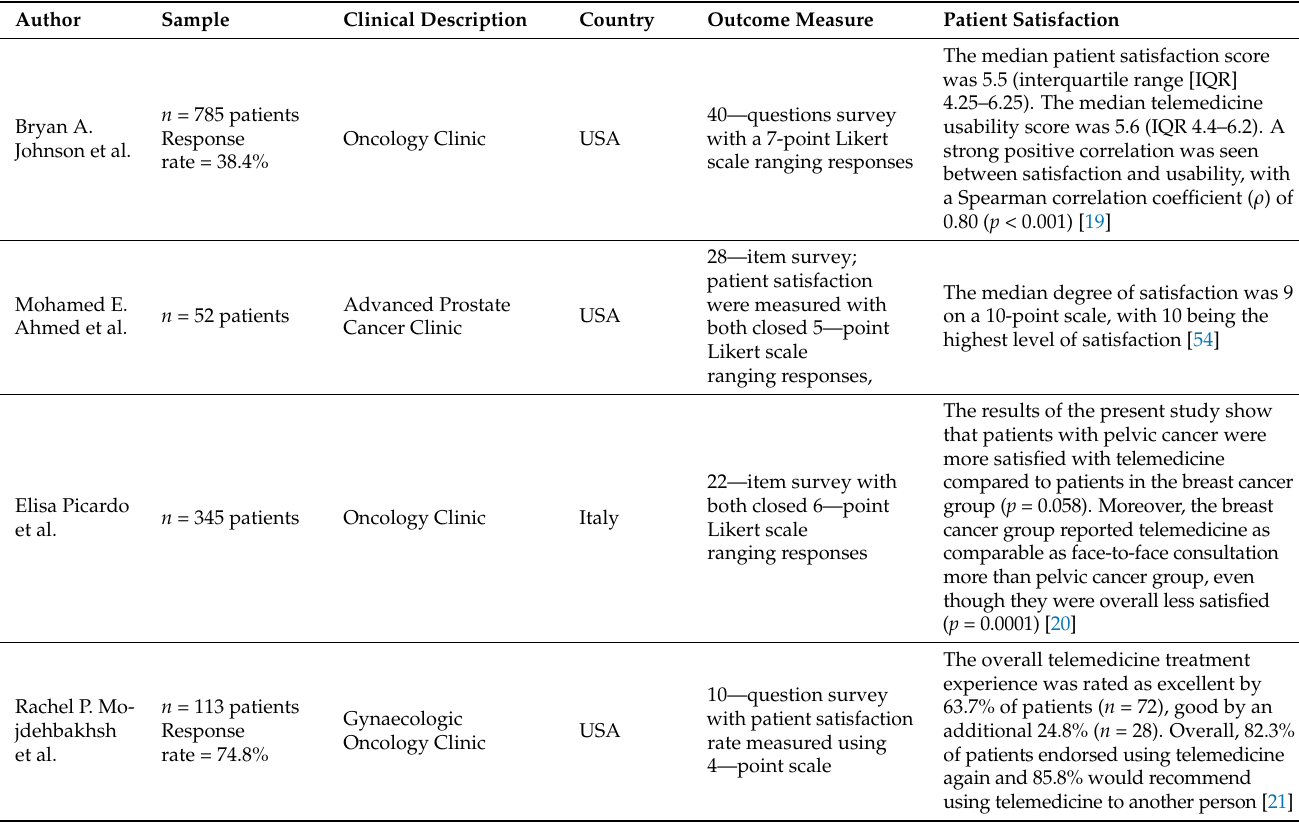
Table 1. Summary of the studies on patient’s satisfaction with